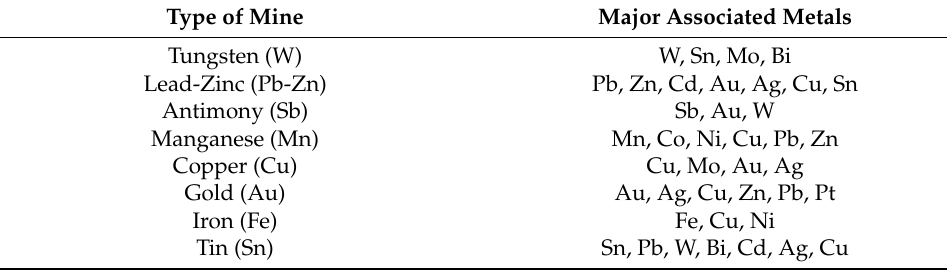
Table 2. Geological characteristics of various metal mines.